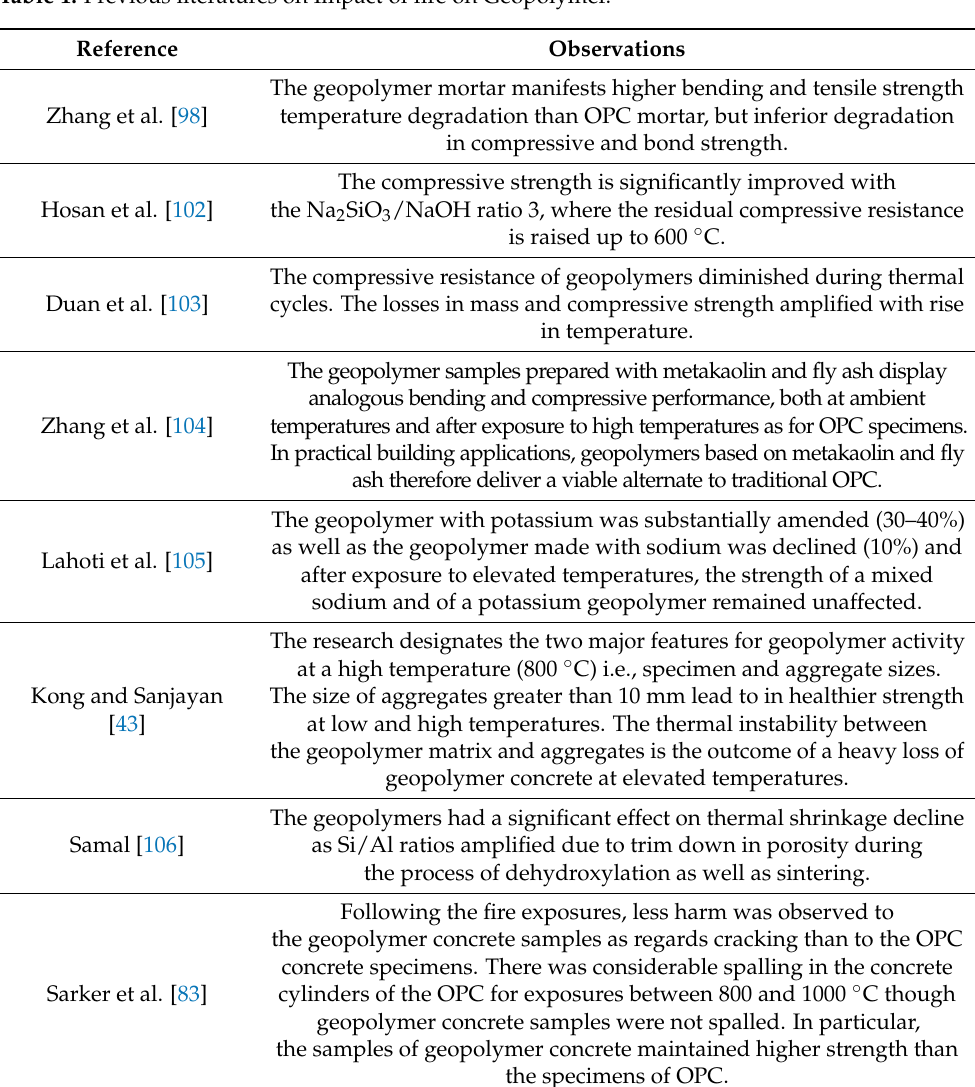
Table 1. Previous literatures on Impact of fire on